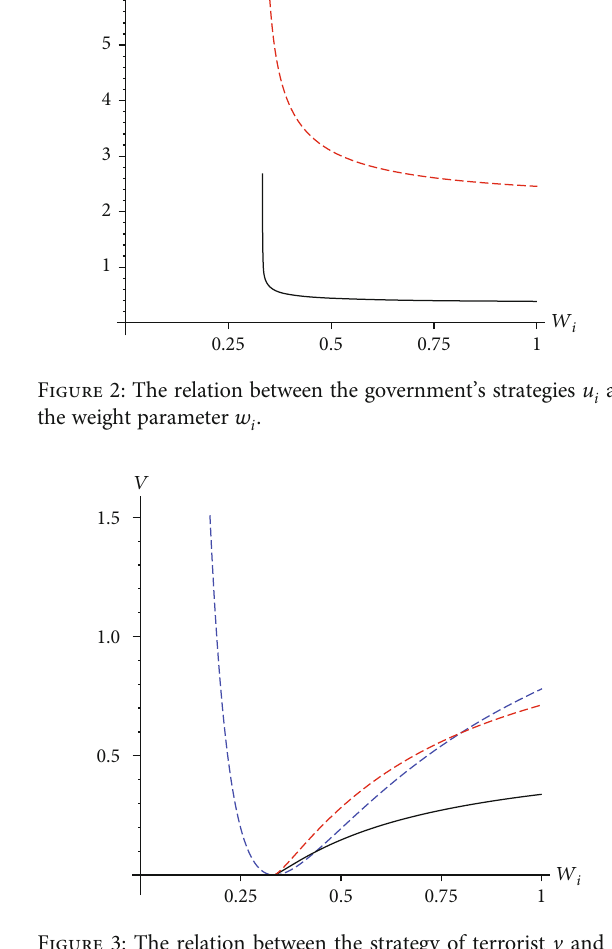
Figure 3: The relation between the strategy of terrorist v and the weight parameter of each government w i